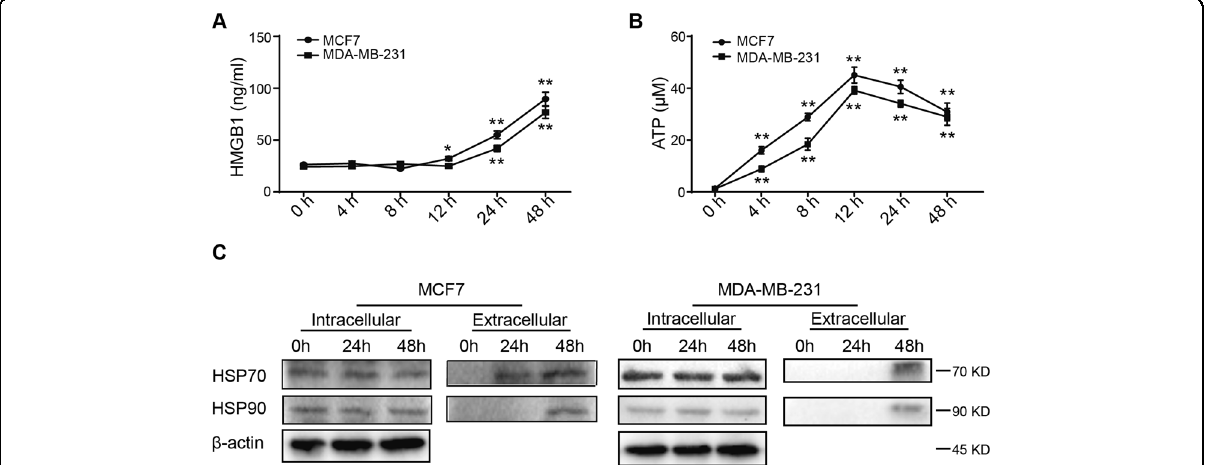
Fig. 2 Oleandrin induces HMGB1 and ATP releasements. MCF7 and MDA-MB-231 cells were treated with oleandrin and culture supernatants were collected 0, 4, 8, 12, 24, and 48 h after treatment. A Secreted HMGB1 was detected by ELISA. B ATP secretion was detected by chemiluminescence assay. Data were acquired from three independent experiments. * p < 0.05, ** p < 0.01 vs. 0 h cells. C Cell supernatants were collected and concentrated at 0, 24, and 48 h after oleandrin treatment. At the same time cell lysates were collected. The expression of HSP70 and HSP90 were detected by western